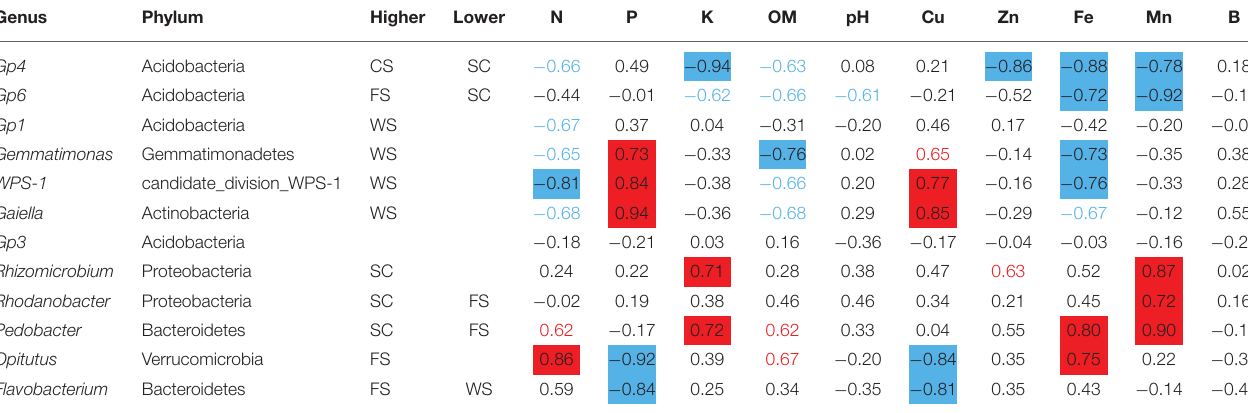
TABLE 2 | Relationships between dominant bacterial species and soil physico-chemical properties.